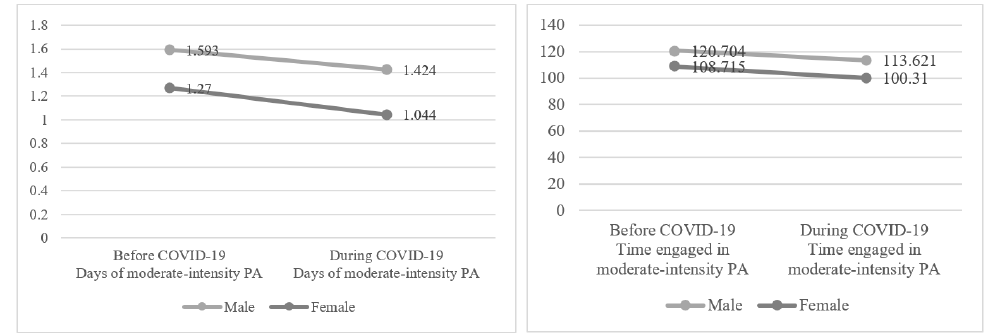
Figure 3. Changes in moderate-intensity PA by gender before and during COVID-19. Note: Time represents the number of minutes exercised per week.